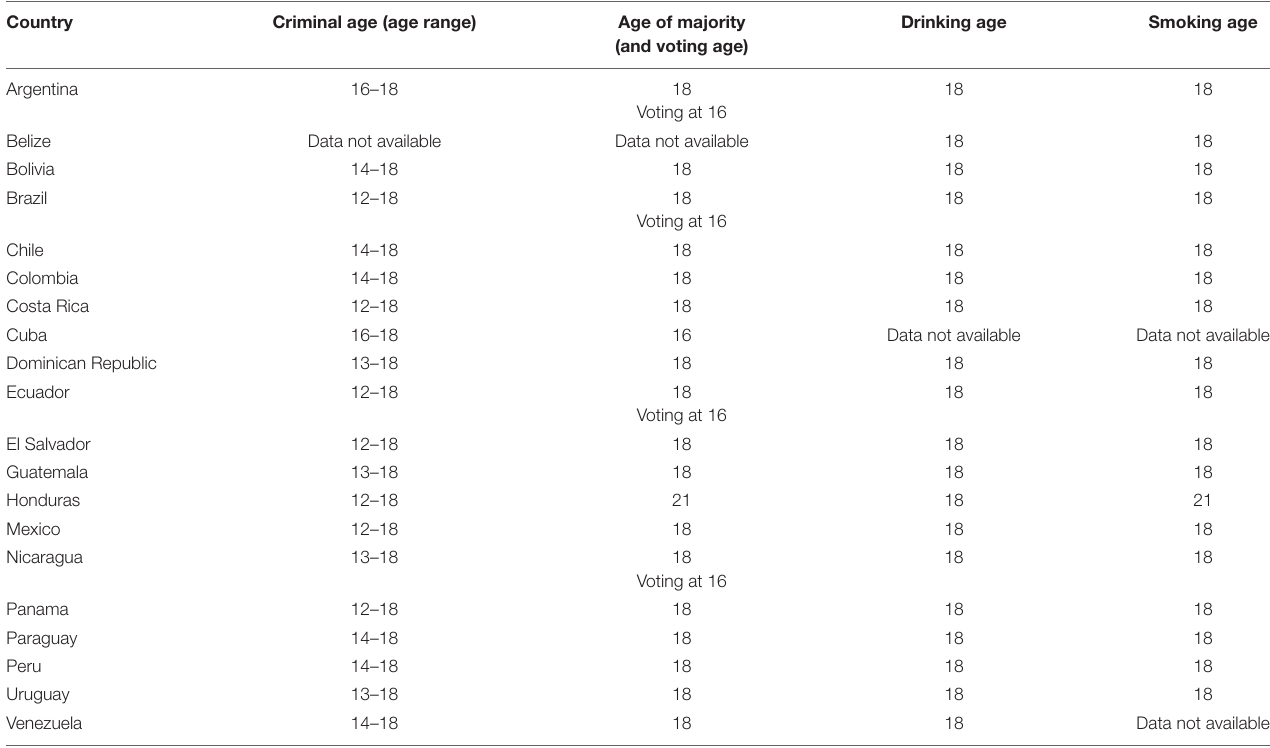
TABLE 1 | Minimum ages to exercise certain rights or to consume certain